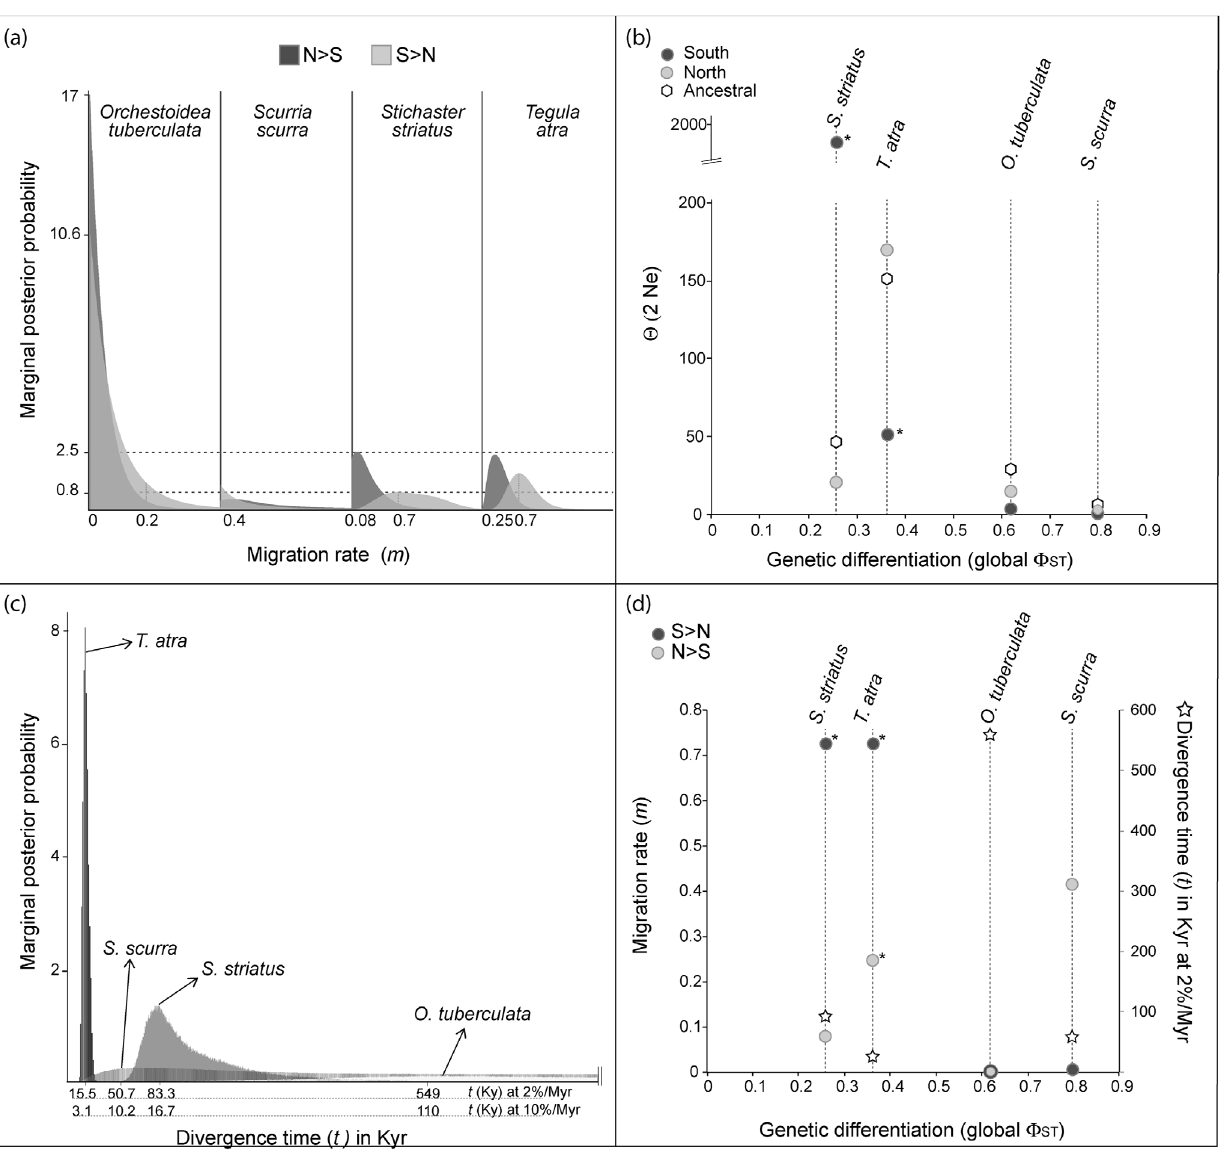
Figure 5. Isolation-with-migration analysis of four species with significant structure across the 30 u S biogeographic break. (a) Marginal posterior probability distribution of migration rate estimates in each direction for each species. (b) Estimated H (2 Ne) values for each biogeographic region (north and south) as well as the ancestral H against genetic differentiation (global W ST ). Asterisks denote estimated H 95% HPD that do not overlap with either ancestral H or the estimated H in the other biogeographic region. (c) Marginal posterior probability distributions of divergence time ( t ) estimates expressed in thousands of years (Kyr). Divergence time estimates were scaled using 2% and 10% per million year substitution rates. (d) Highest probability value of estimated migration rates ( m ) in each direction, and divergence times ( t ) expressed in thousands of years (Kyr) scaled using 2% per million year substitution rate, versus genetic differentiation (global W ST ). Asterisks indicate significant values based on the likelihood ratio